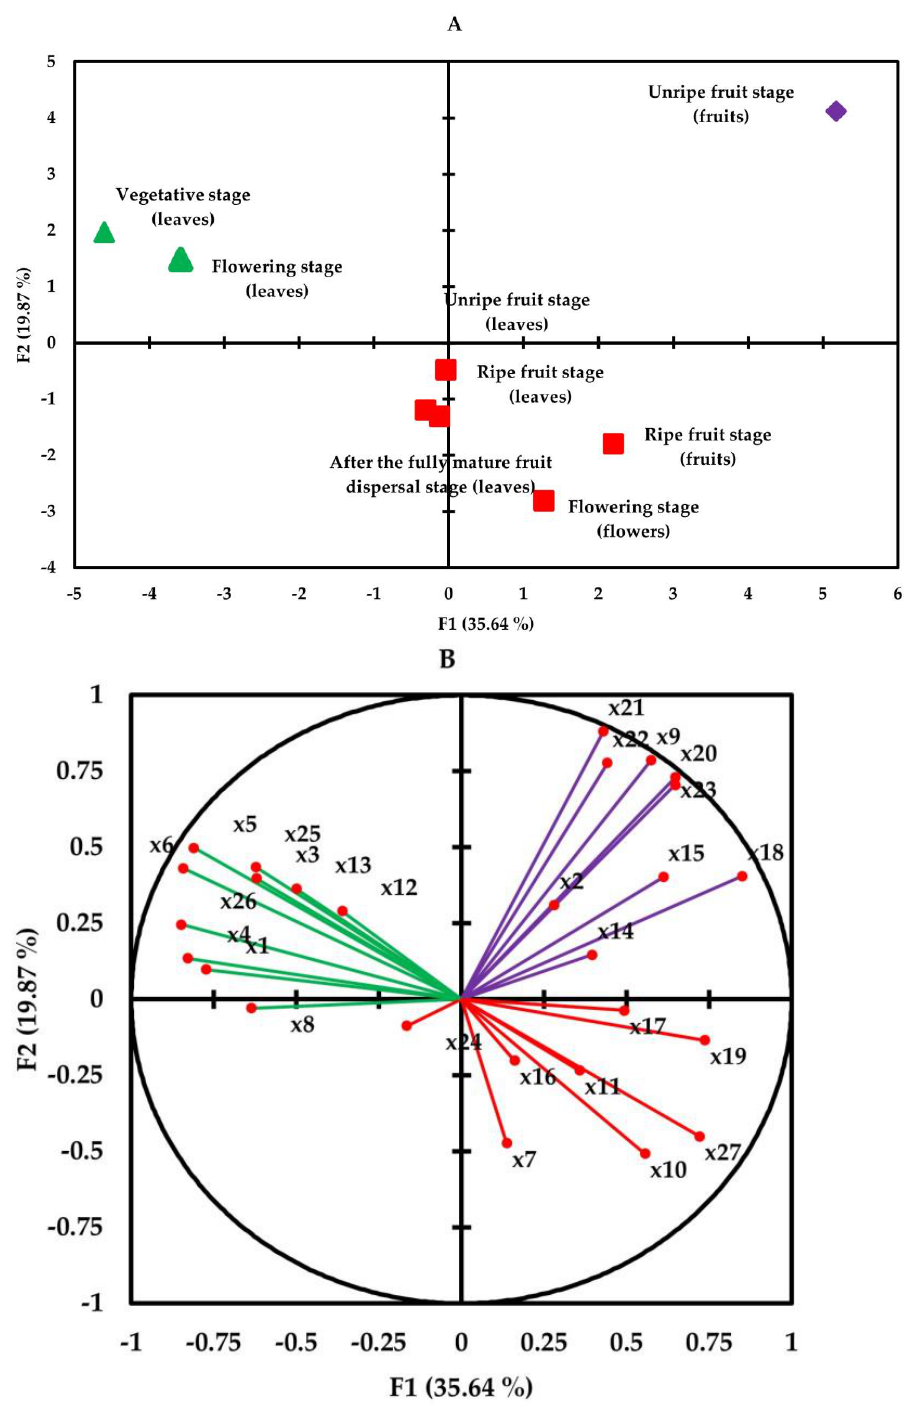
Figure 4. A: Biplot obtained from first and second components of myrtle organs based on different phenological stages ( A ) and phytochemical compounds ( B